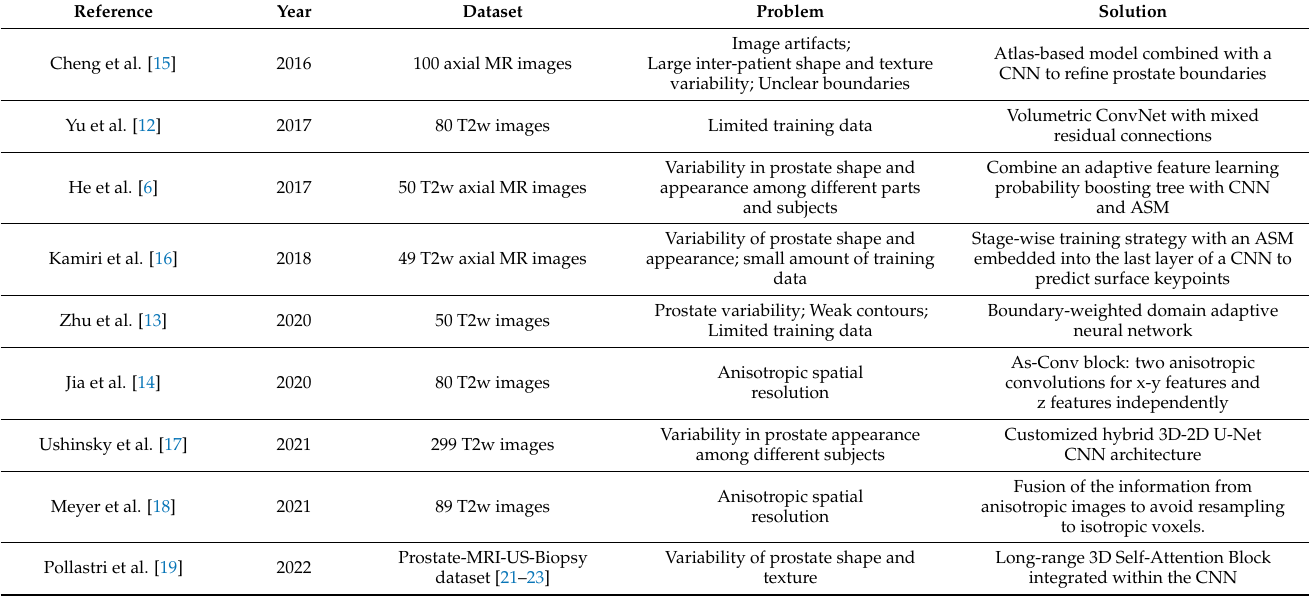
Table 1. Previously published methods for prostate segmentation in MR images. The table presents the problem addressed for each method, along with details of the datasets and the proposed